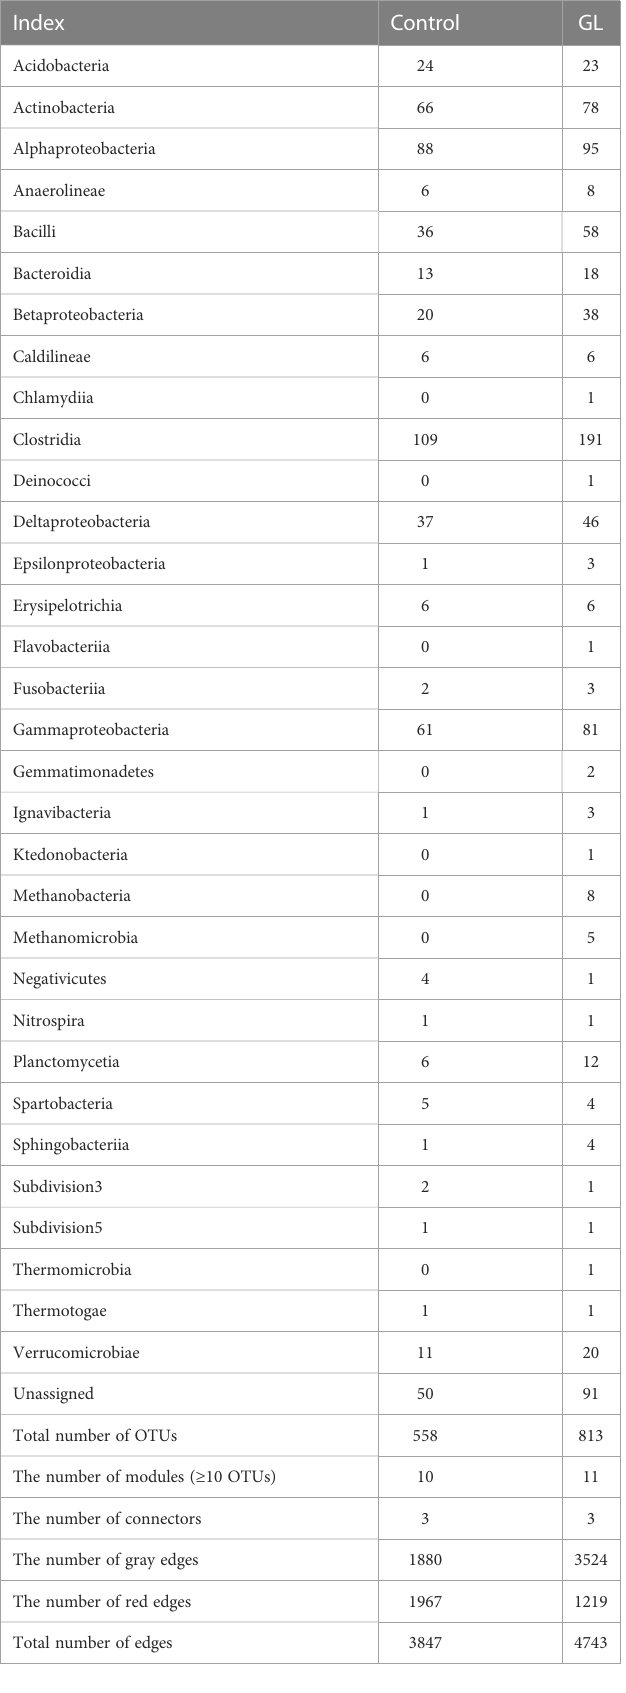
TABLE 3 The composition of the ecological